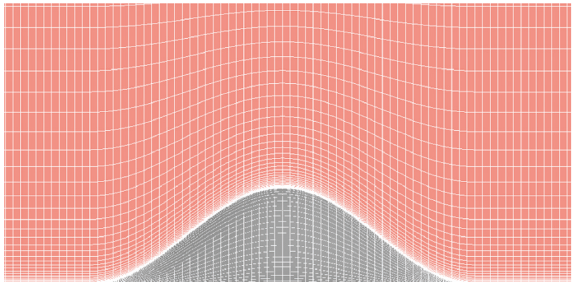
Figure 1: Cross section of the mesh system for an isolated peak configuration. A uniform Cartesian mesh is used in the horizontal direction, and nonuniform stretching is used in the vertical